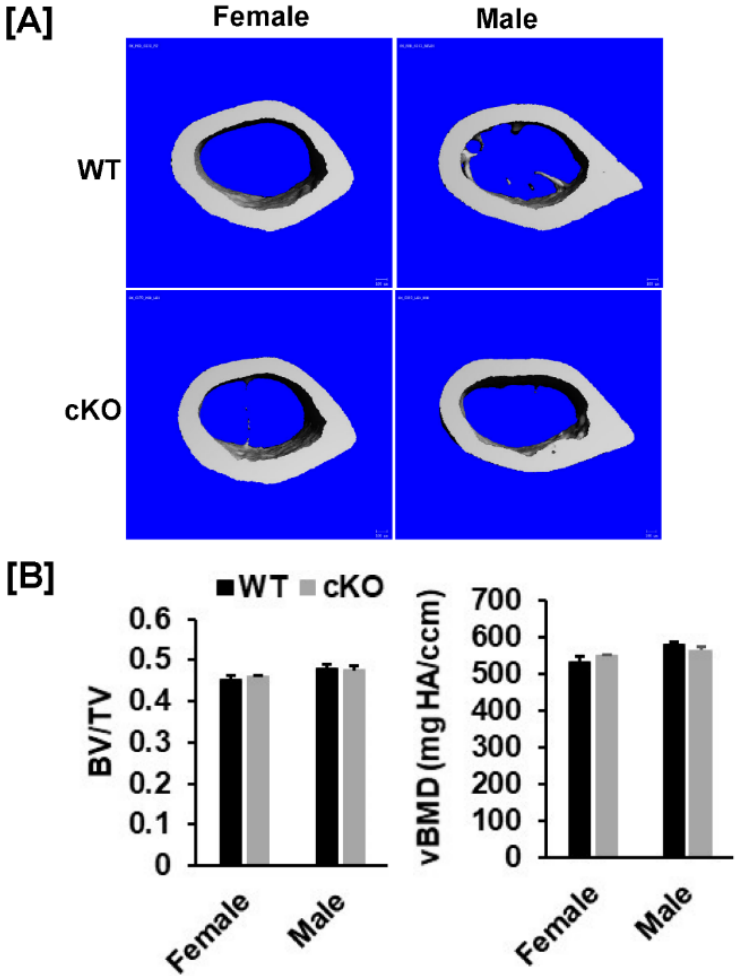
Figure 4. There were no changes in cortical parameters of the femur of the Phd3 cKO mice at 16 weeks of age. ( A ): Micro-CT images of the cortical bone of the femur. ( B ): Quantitative data of cortical BV/TV and BMD of the femur.